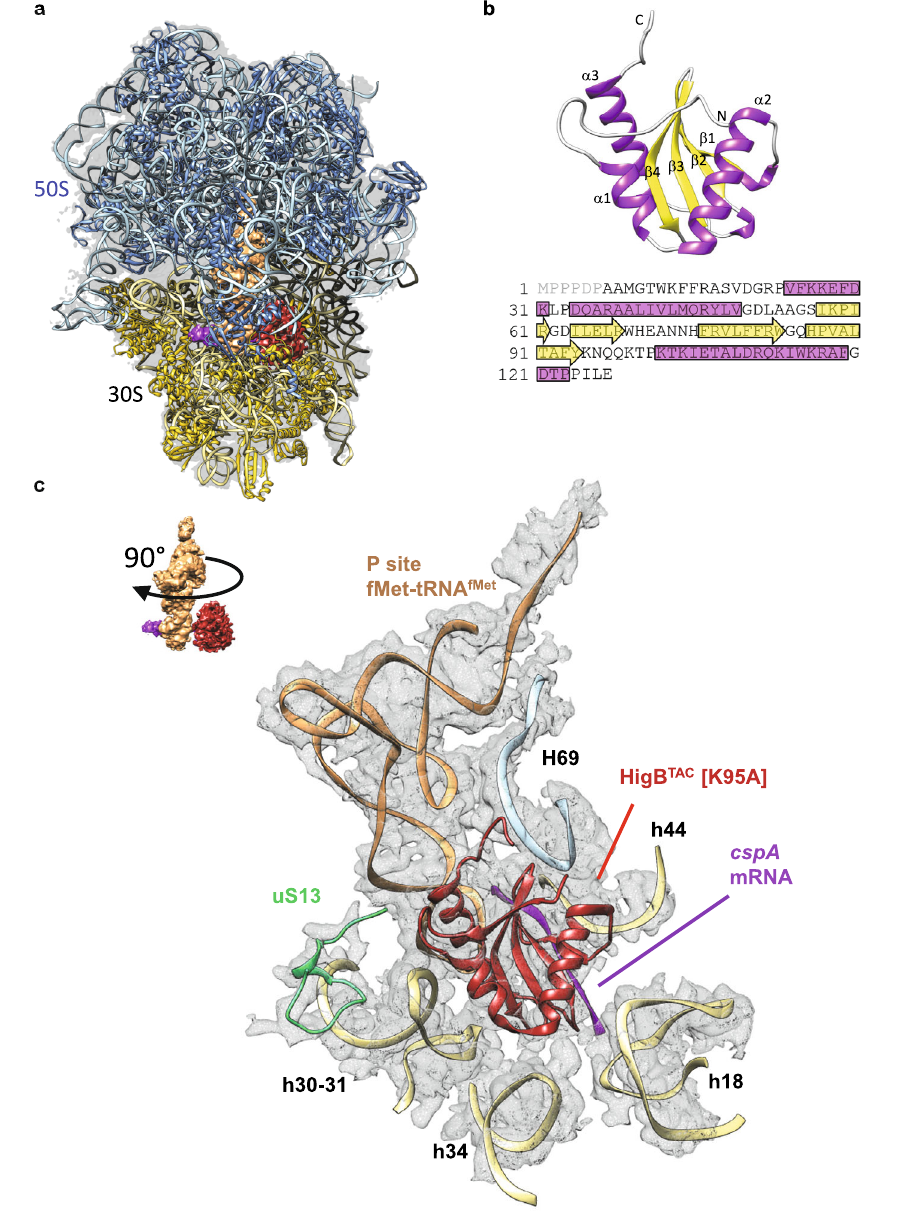
HigB TAC [K95A] (red), its target cspA mRNA (purple), fMet-tRNA fMet (orange), and the atomic models for the 50S (blue) and 30S (yellow) ribosomal subunits. b Crystal structure of HigB TAC [K95A]. The N-terminus, C-terminus, and the secondary structure elements are indicated. The sequence of the toxin is shown underneath with the secondary structure element highlighted ( α -helix in pink, β -strand in yellow). The fi rst six residues (light gray) are not visible in the crystal structure. c Close-up of the interactions between HigB TAC [K95A], the cspA mRNA, and the translating ribosome, rotated by 90° with respect to the structure in a . The HigB TAC [K95A] is red; the P-site fMet-tRNA fMet is orange; the cspA mRNA is purple; the uS13 ribosomal protein is green; the 16S rRNA is light yellow; the 23S rRNA is light blue; and the cryo-electron density map is a gray mesh. For clarity, 16S and 23S α -helices are